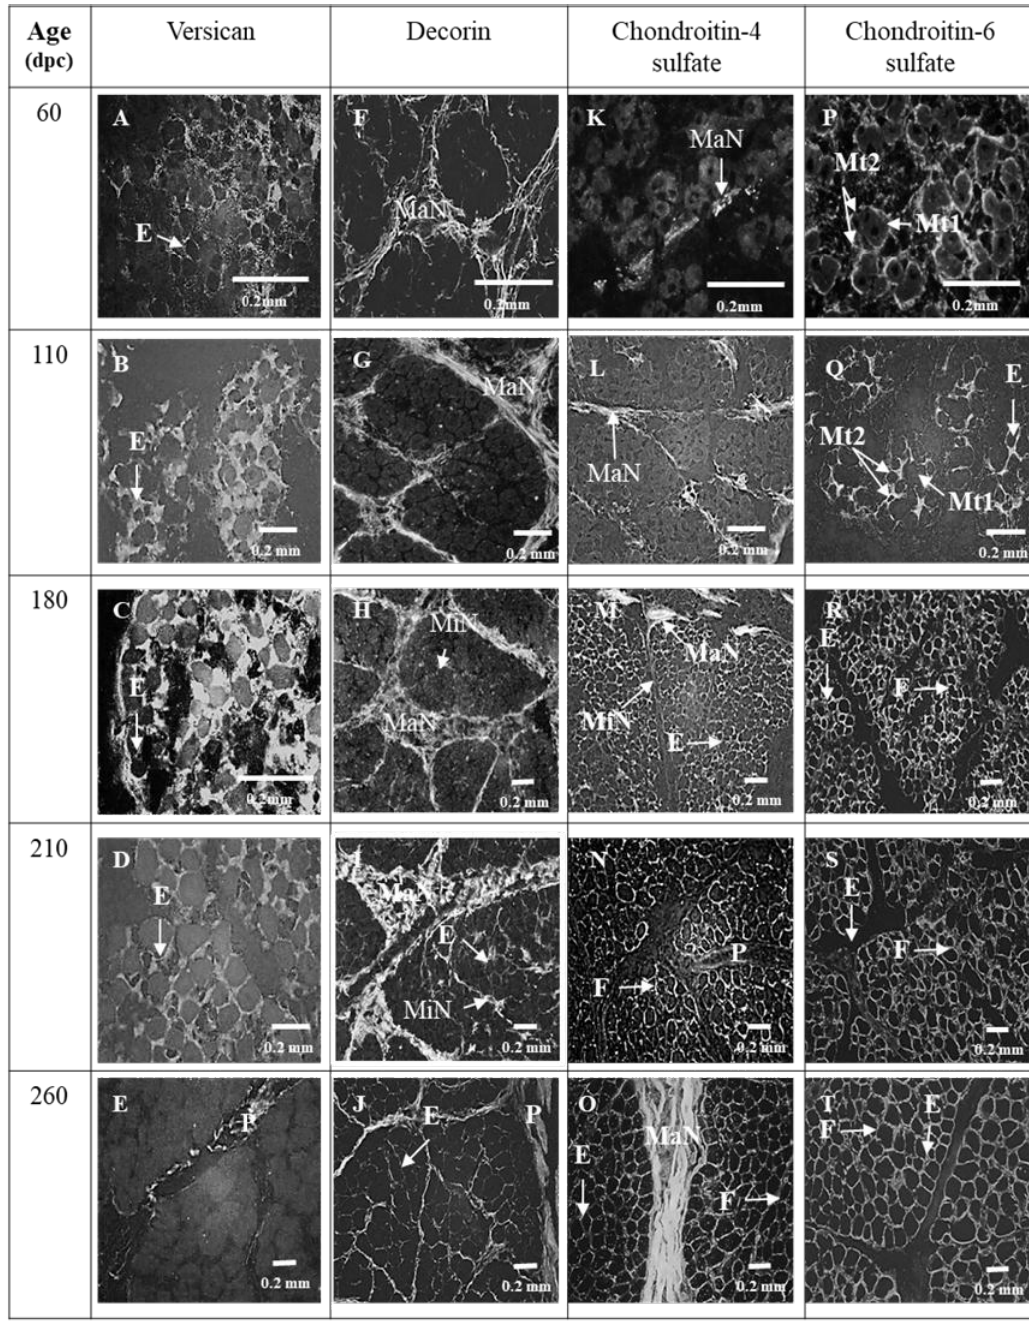
Figure 3. Immunohistochemical labelling with antibodies against versican ( A , B , C , D , E ), decorin ( F , G , H , I , J ), chondroitin-4-sulfate ( K , L , M , N , O ), chondroitin-6-sulfate ( P , Q , R , S , T ) of transverse sections of foetal Semitendinosus muscle at 60, 110, 180, 210 and 260 days post-conception (dpc). (Major (MaN) and minor (MiN) networks of perimysium (P), E: endomysium, Mt1: primary myotubes, Mt2: secondary myotubes, F: muscle fiber).